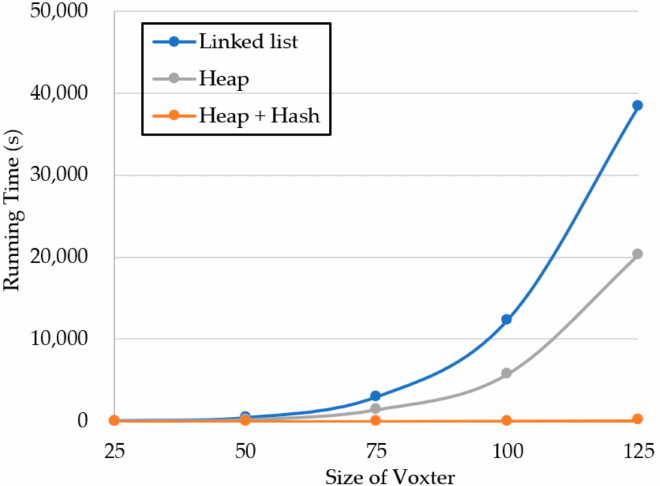
Figure 15. Di ff erence in the performance of the algorithm based on the implementation of three data structures in C ++